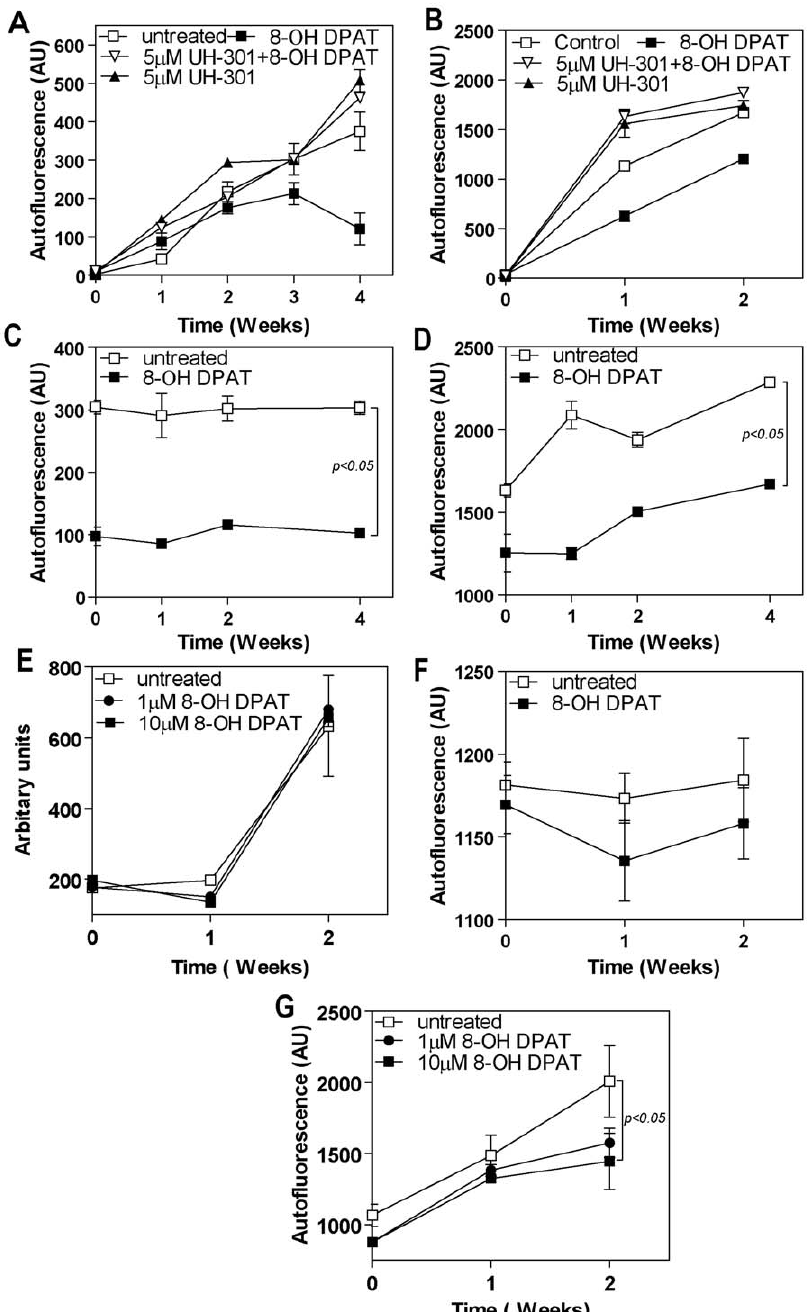
derived ( B ) lipofuscin accumulation in cultured RPE. C, D - To determine if the effect of 8-OH DPAT was sustained following discontinuation of 8-OH DPAT treatment, 8OH DPAT treatment was discontinued after 28 days and the cells maintained in basal medium ( C ) or fed POS ( D ) for a further 28 days. E, F, G - To assess the ability of 8-OH DPAT (10 uM) to remove pregenerated lipofuscin, 8-OH DPAT was added every second day for 28 days after: E – 28 days accumulation of autophagy-derived lipofuscin; F - cultures were fed mature lipofuscin granules; G - 14 days accumulation of POS- derived lipofuscin. Data represent the mean of three experiments.